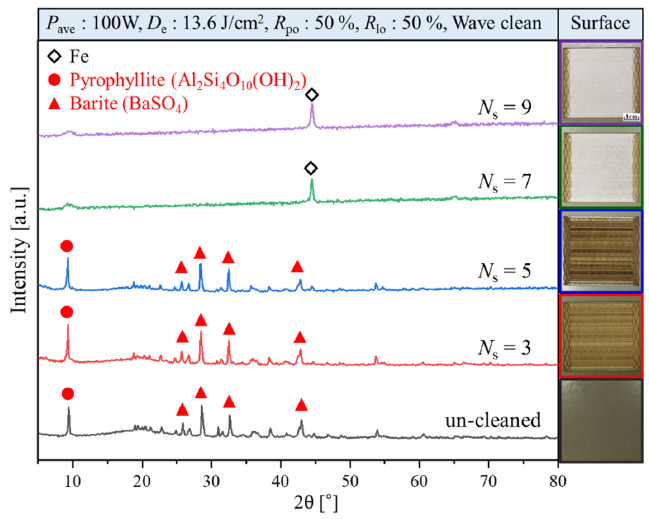
Figure 7. XRD analysis results of the specimen before and after laser cleaning using a wave clean beam pattern.